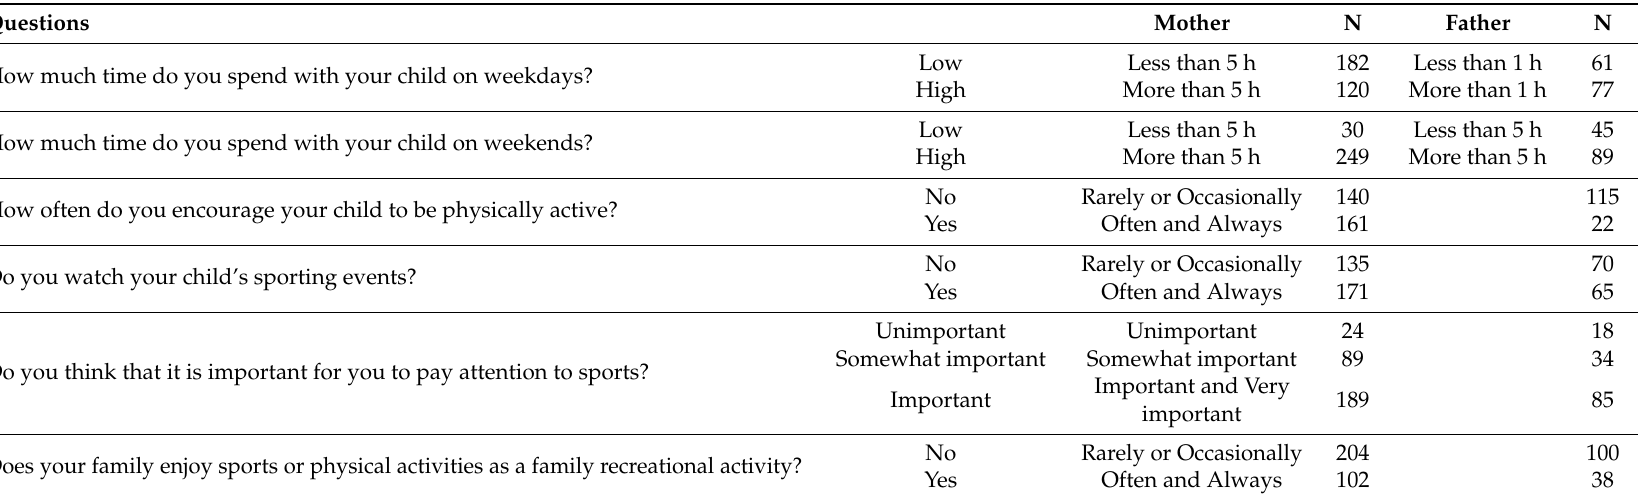
Table 2. Responses of children’s’ physical activity to parental